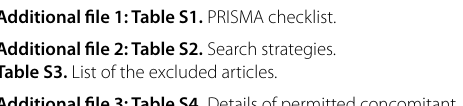
Additional file 2: Table S2. Search strategies. Table S3. List of the excluded articles. Additional file 3: Table S4. Details of permitted concomitant